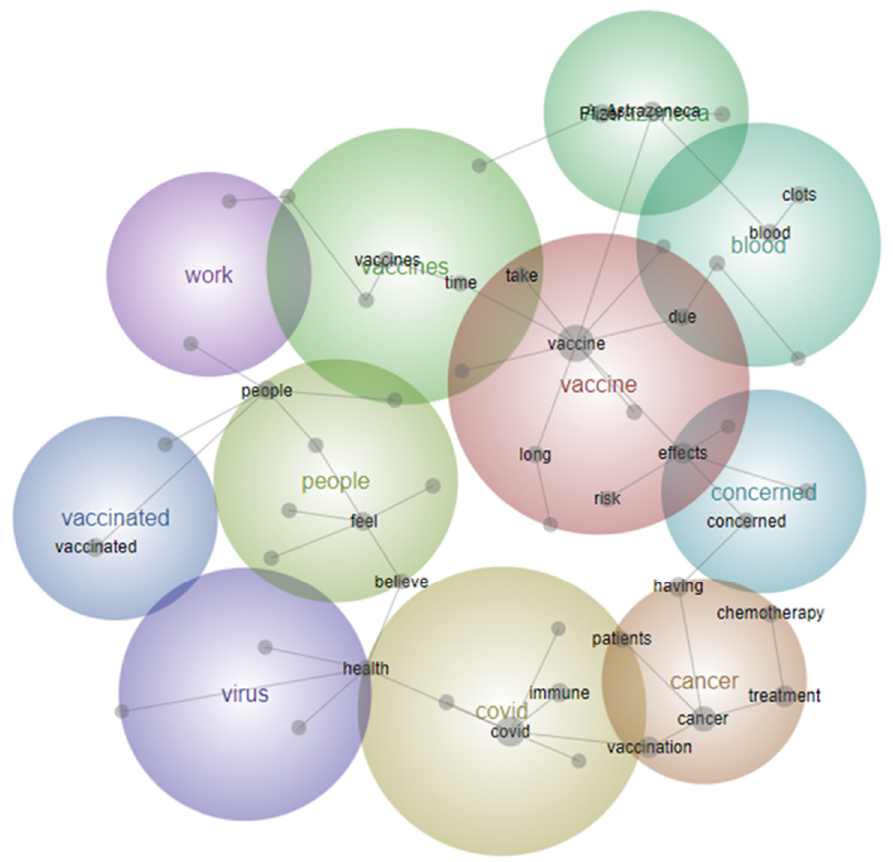
Figure 3. Leximancer-generated concept map of comments from people with cancer, multiple sclerosis, and diabetes.